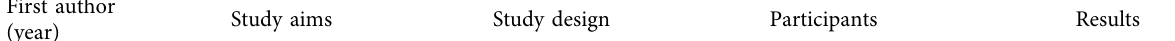
Table 5: Overview of studies about the use of grand challenges in higher education